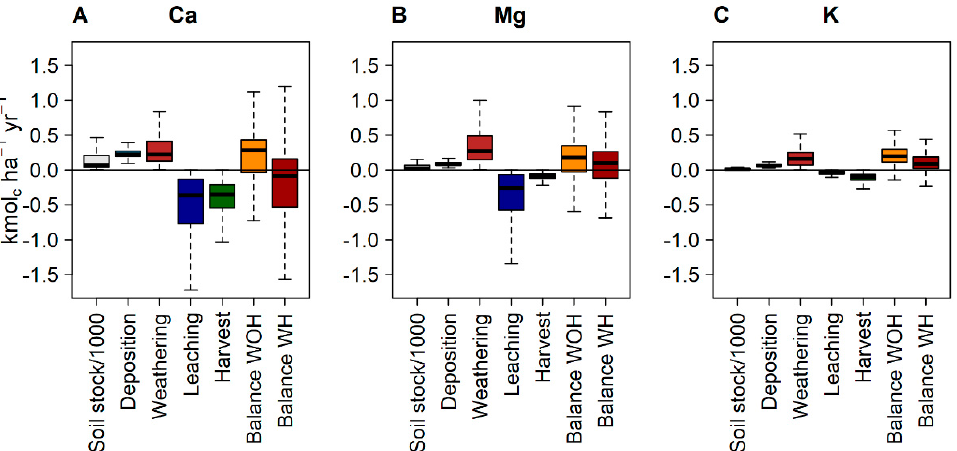
Figure 3. Median and range data for calcium ( A ), magnesium ( B ) and potassium ( C ) of soil stocks, deposition, weathering, leaching, harvest removal, nutrient balance without harvest (WOH), and nutrient balance with harvest (WH) for NFI tracts in Germany (for Ca and Mg excluding carbonate sites; harvest export for scenario REAL).